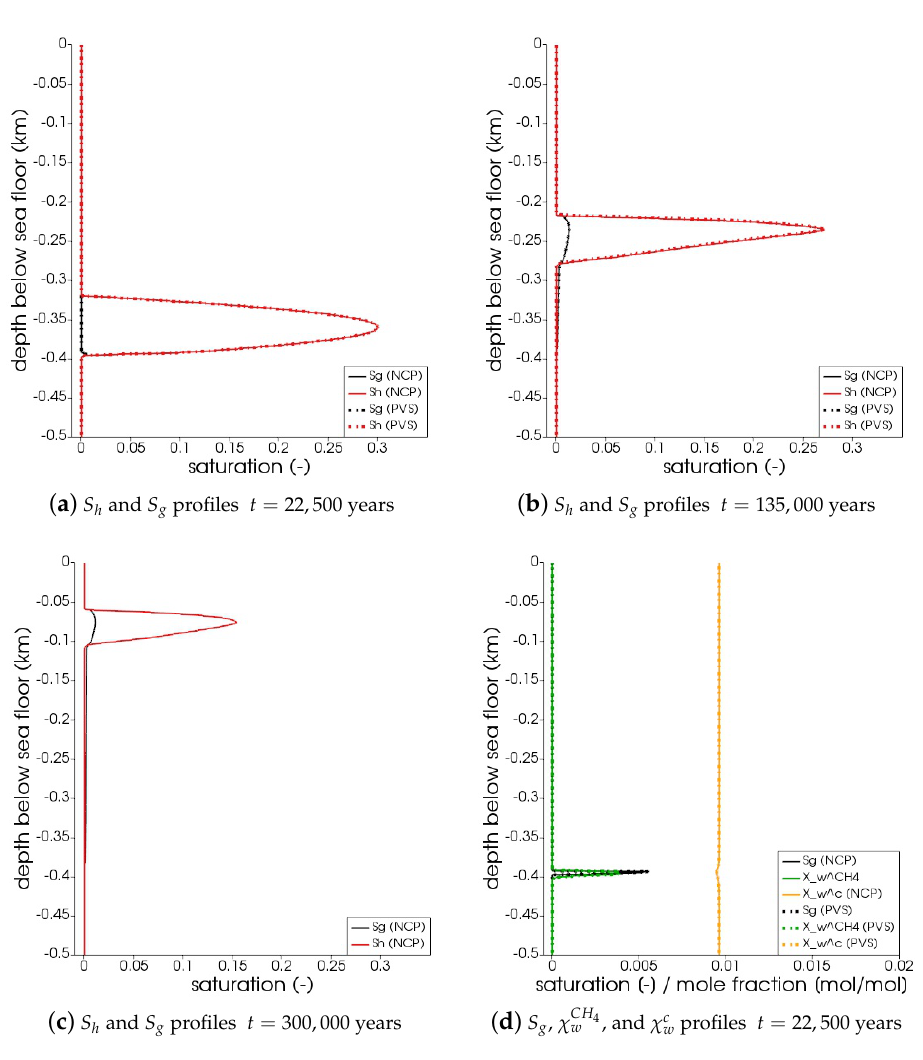
Figure 4. Numerical results for Example 1 (Section 4.1). The figure compares the NCP and the primary variable switching (PVS) schemes in terms of the cumulative CPU time required to solve the problem and the evolution of the time-step size during the simulation.